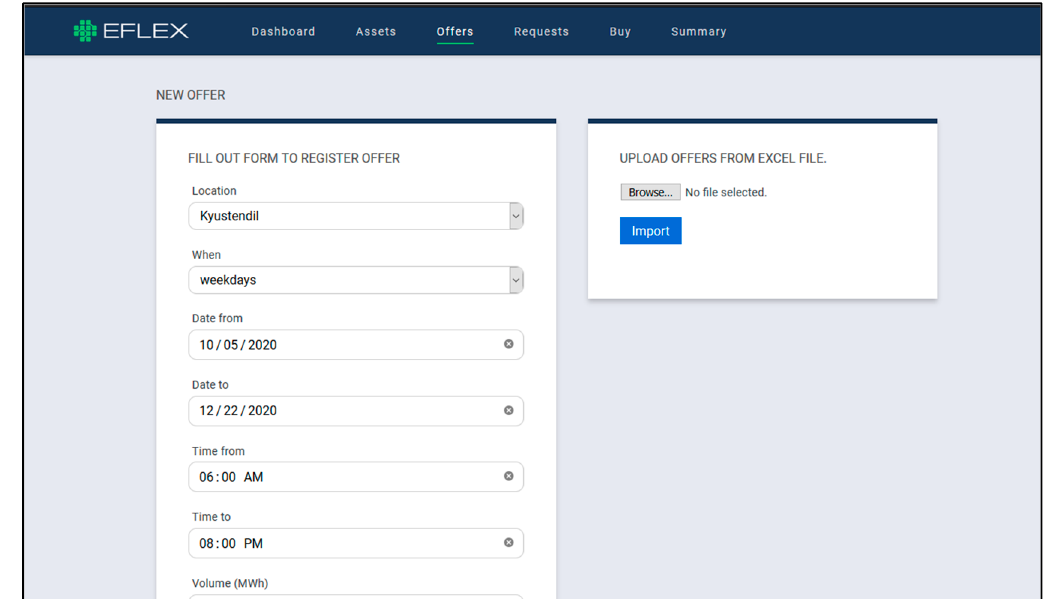
Figure 19. Welcome dashboard the trading eFLEX platform.